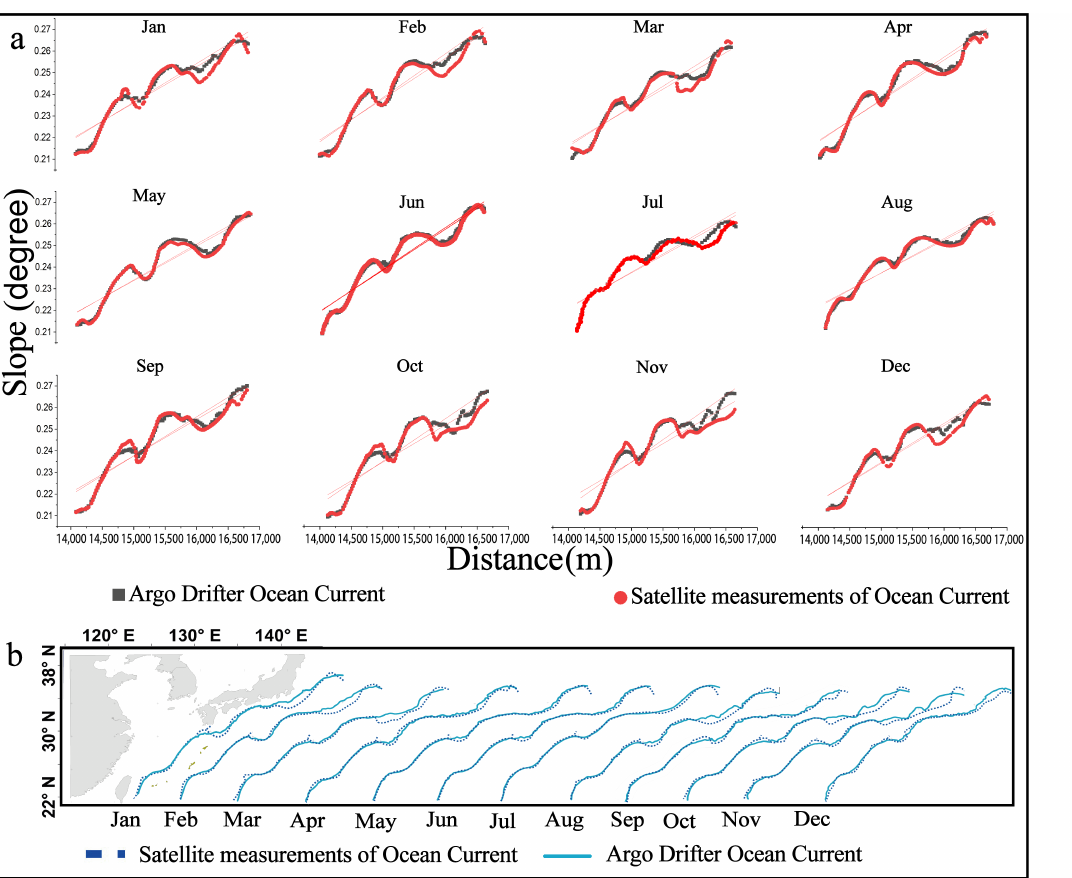
Figure 7. Correlation of KC from Argo drifter (grey) and Satellite rendered (red) ( a ) illustrates the variation in slope (degree) with distance (meter). ( b ) the climatological spatial variation among KC from drifters and satellite during 1993–2018